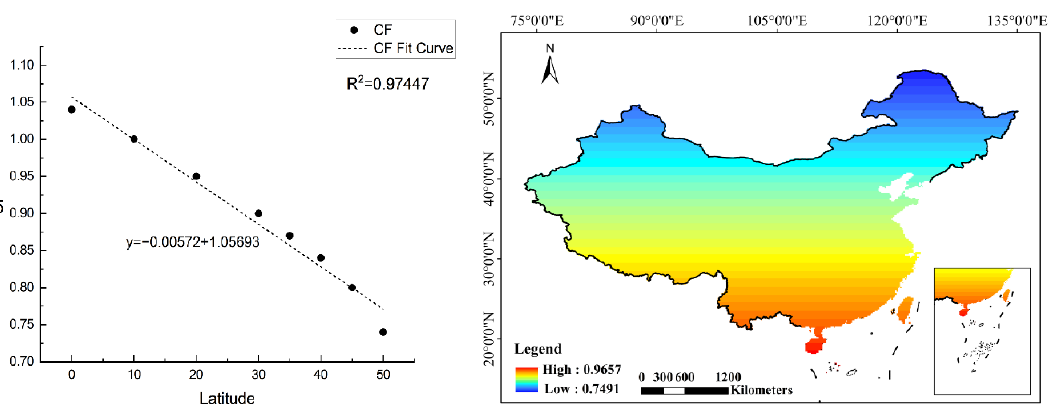
Figure 2. CF-fitted data for January. The left panel shows the linear regression relationship between CF values and latitude, and the right panel shows the fitted spatially continuous CF raster data. The CF values show a negative correlation with latitude.